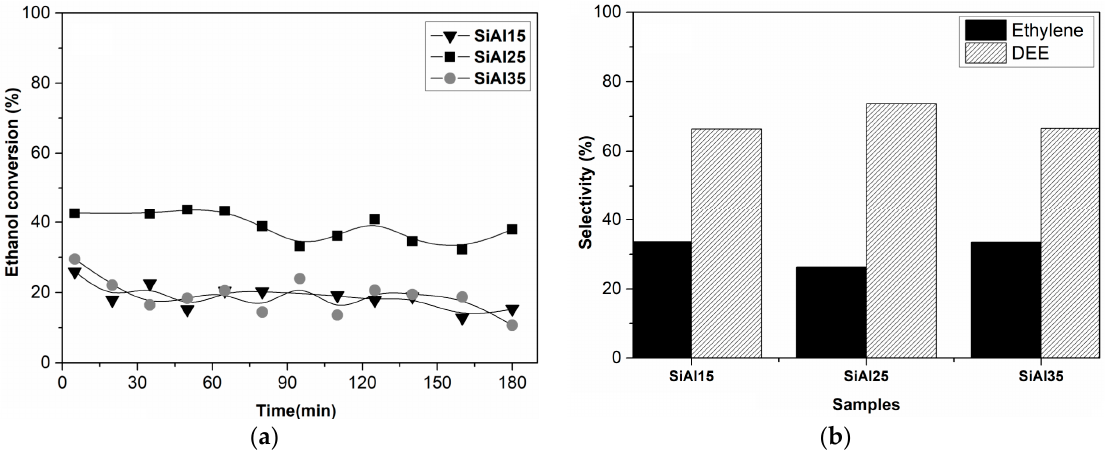
Figure 7. Micrograph of calcined sample SiAl25.